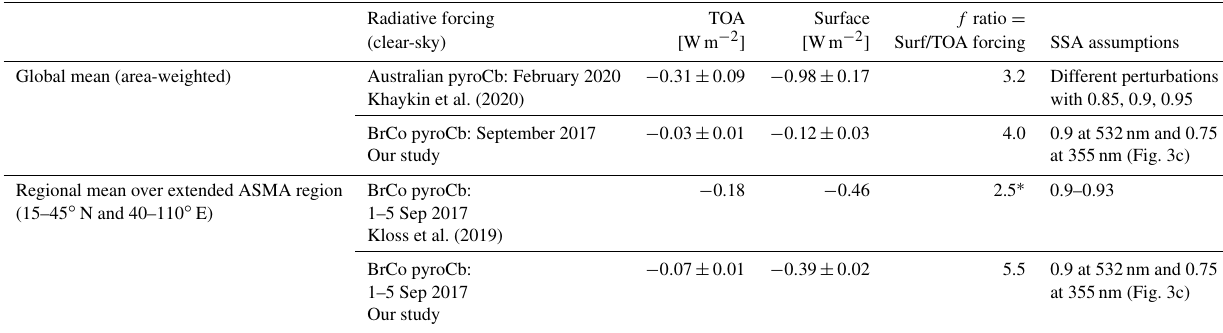
Table 1. Comparison of clear-sky TOA and surface radiative forcing estimates from recent stratospheric smoke perturbations.